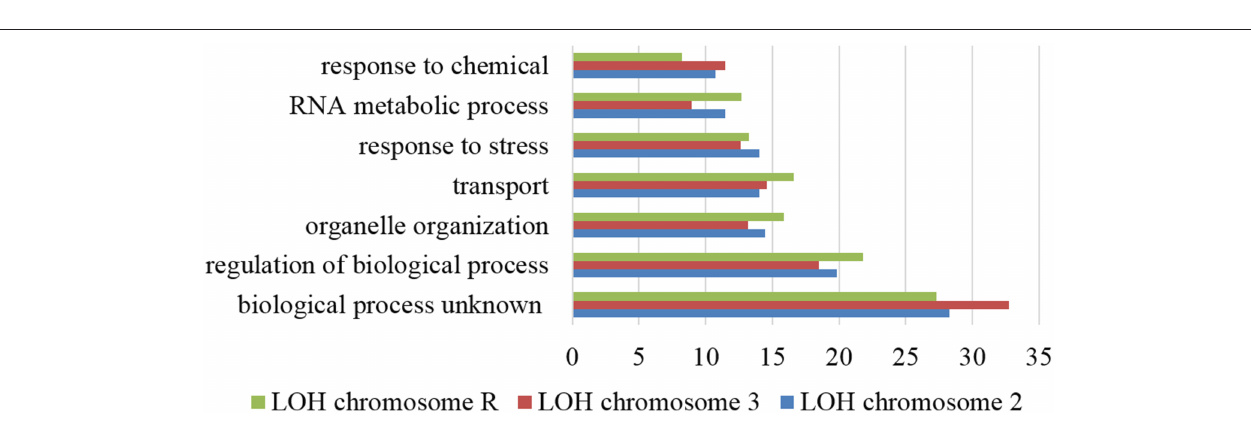
Frontiers in Microbiology |